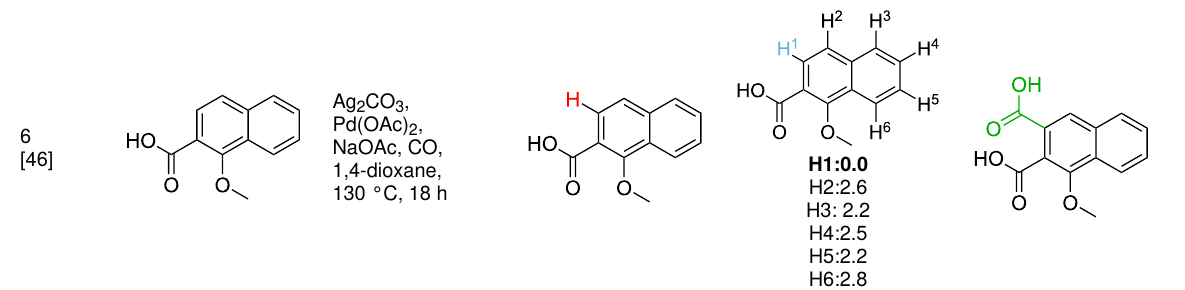
Table 3: A comparison of the published experimental results with the computational predictions for the Pd(OAc) 2 -catalysed reactions. a (continued)